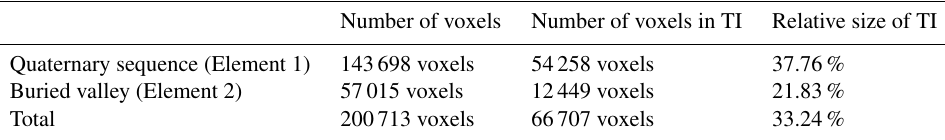
Figure 2. Schematic overview of the proposed workflow from input data (left) through data analysis and simulation setup (middle) and geostatistical simulation (right). Table 2. Summary of the number of voxels for simulation grid and TIs. The relative sizes of the TIs are calculated as the ratio between the number of voxels in the TI and the number of grid